Question: Give a one-sentence summary of this figure.
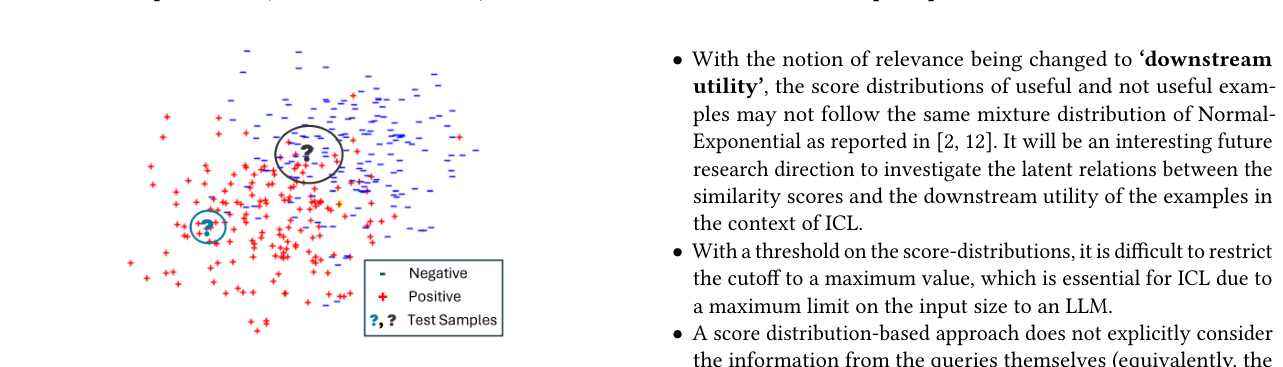
Answer: Motivation behind using a variable sized neigh- borhood for 𝑘-NN classification [87]: An instance close to a decision boundary (black ‘?’) is likely to have a higher hetero- geneity in its class distribution, thus indicating the necessity of a larger neighborhood for an effective classification.